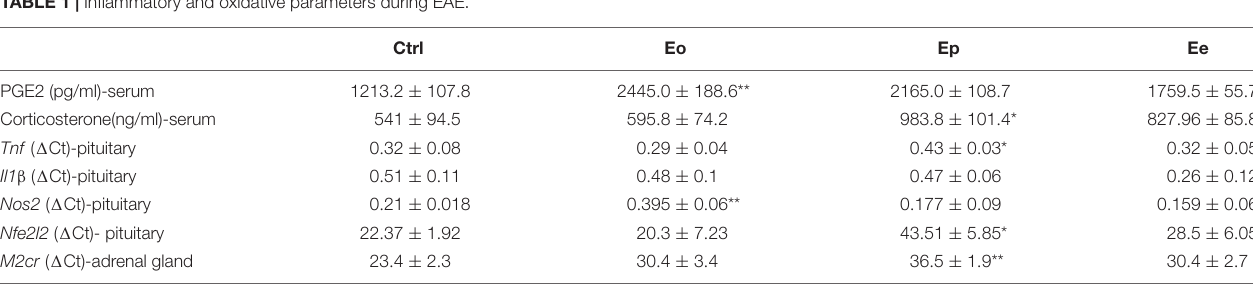
FIGURE 4 | Stereological analysis of the temporal changes of ACTH cells. (A) Changes in the volume of the pituitary during EAE. Variation of ACTH secreting cells in the pituitary in volume density (B) , number (C) , and volume of the single cell (D) in the course of EAE. Pituitary from control – C and EAE rats, obtained from different time points—Eo (onset of the disease), Ep (peak of the disease), and Ee (end of the disease), and used for determination in morphometric parameters. Results are given as means ± SEM; * p < 0.05, ** p < 0.01, and *** p < 0.001 on a corresponding day. TABLE 1 | Inflammatory and oxidative parameters during